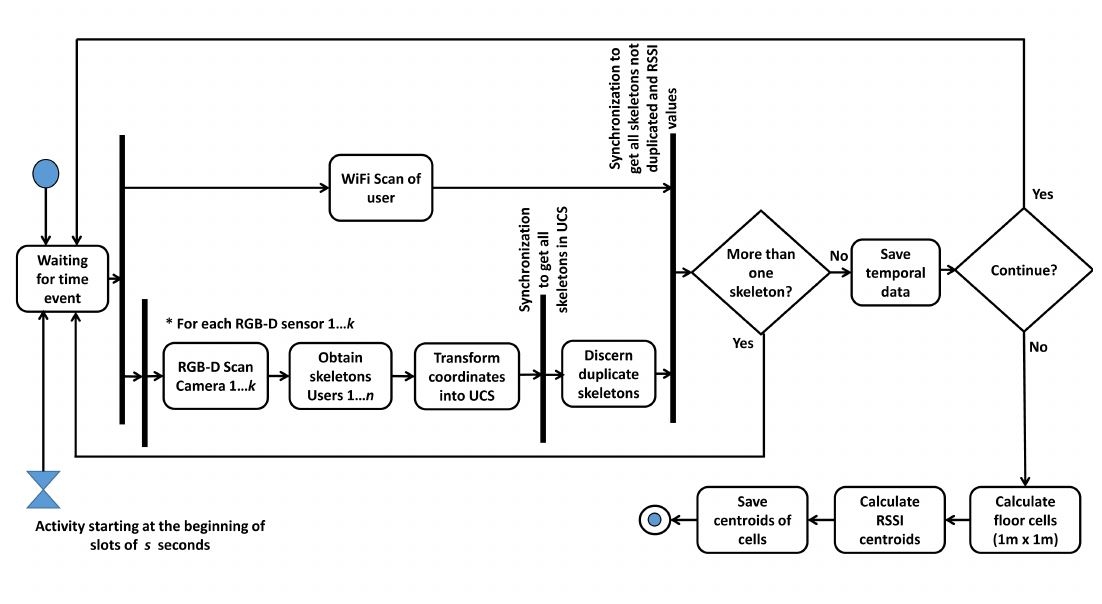
Figure 2. Activity diagram during the Training